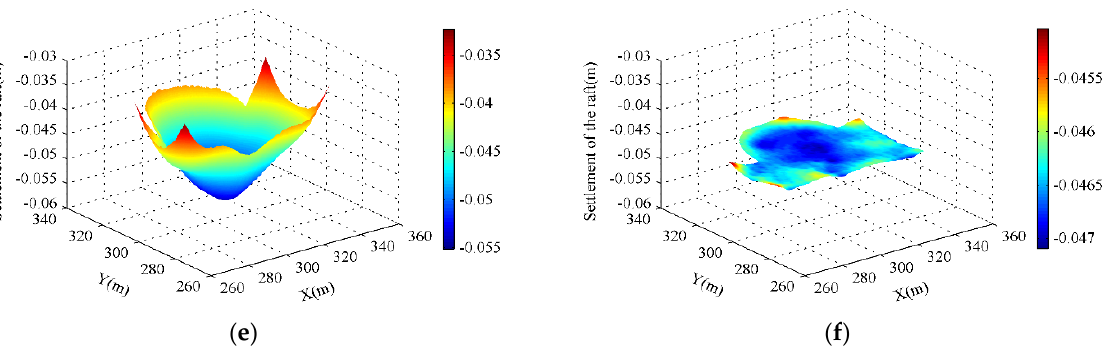
Figure 10. Settlements of the raft in different cases before and after optimization design: ( a ) C1-117-I;